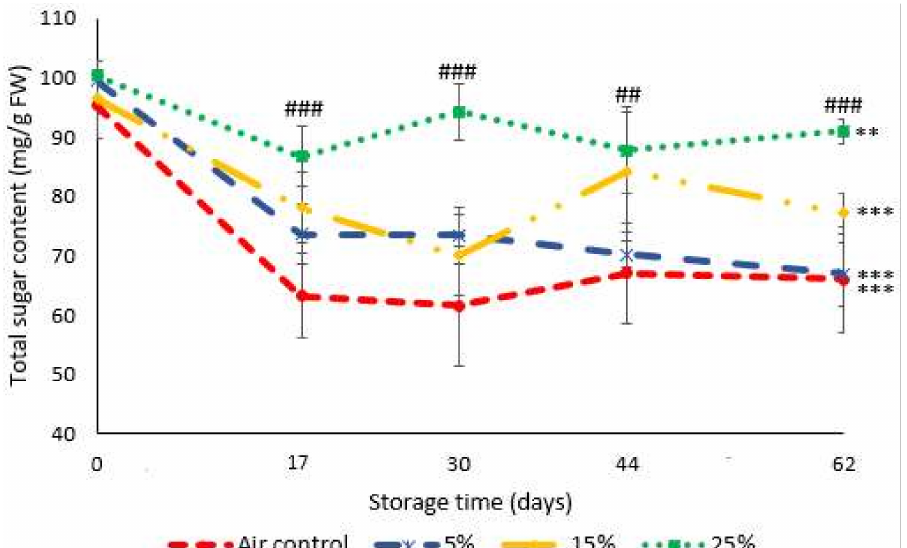
Figure 2. Blueberry ‘Liberty’ fruit total sugar content under the air control and controlled atmospheres (5% CO 2 , 5% O 2 , 90% N 2 (5%); 15% CO 2 , 5% O 2 , 80% N 2 (15%); and 25% CO 2 , 5% O 2 , 70% N 2 (25%)) for different storage times (mg/g FW). **, p < 0.01; ***, p < 0.001 (versus storage = 0, within each storage condition). ##, p < 0.01; ###, p < 0.001 (versus air storage, for each storage time). Table 1. Contents of individual sugars of blueberry ‘Liberty’ fruit for the air control and controlled